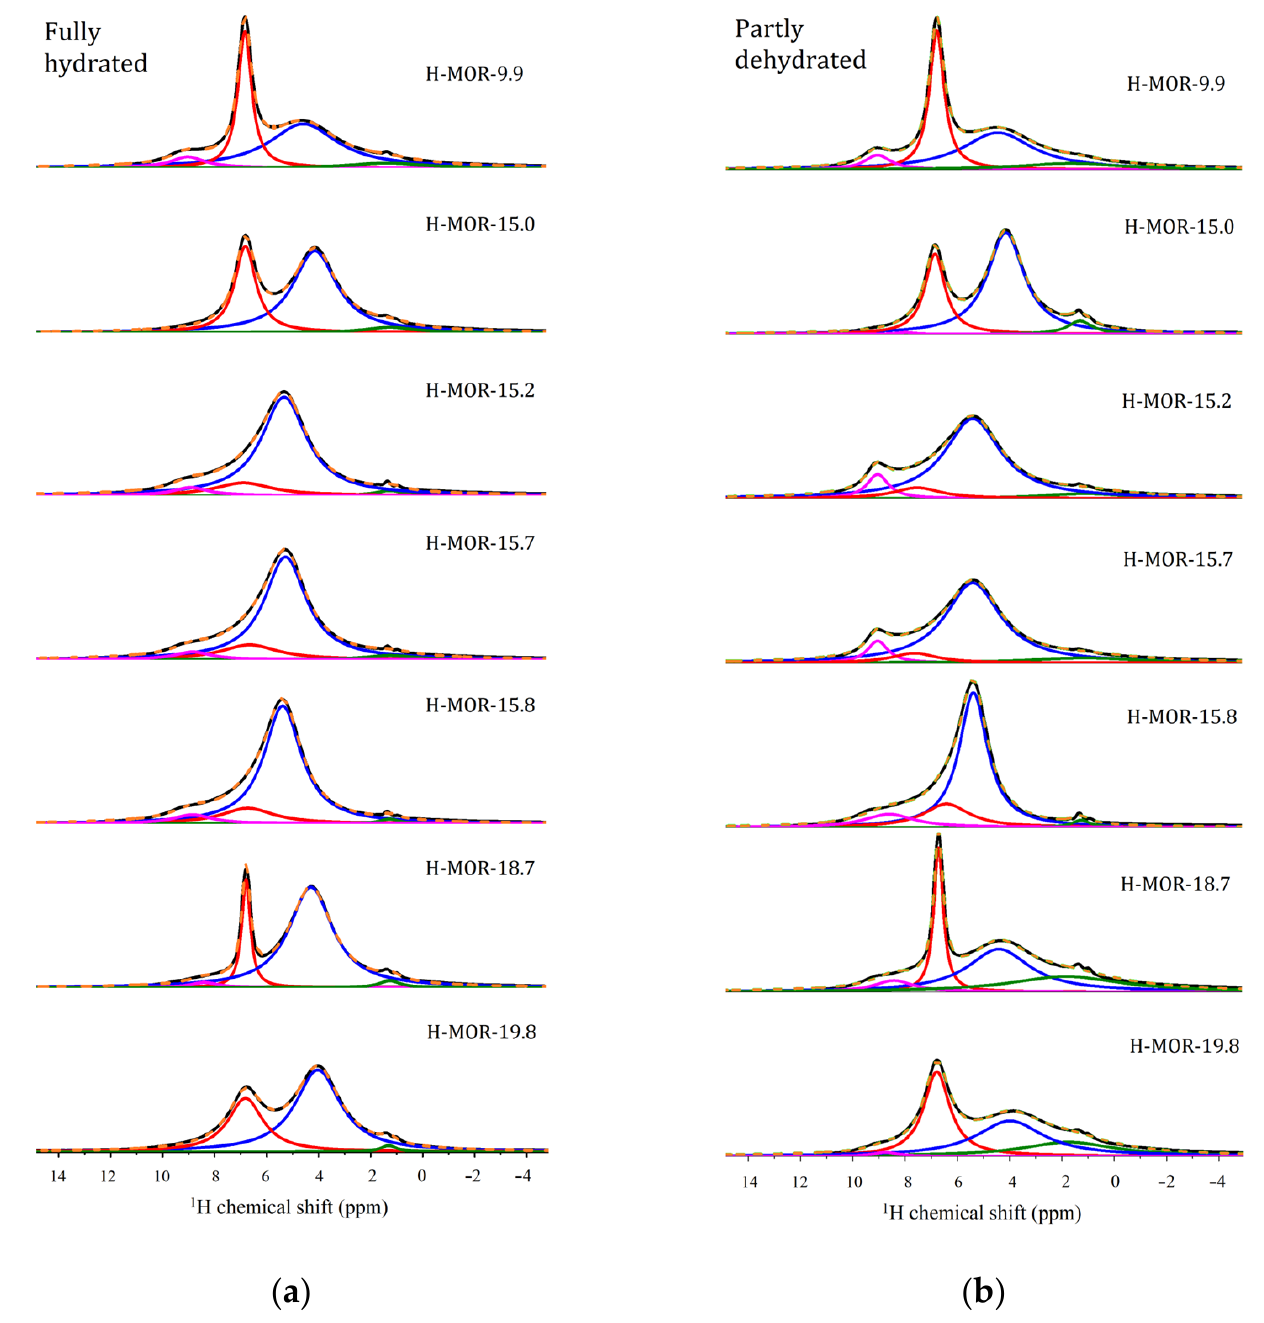
Figure 5. 1 H MAS NMR spectra for the fully hydrated ( a ) and partly dehydrated ( b ) samples and their decomposition in Lorentzian lines. All spectra are recorded at ν rot = 15 kHz.